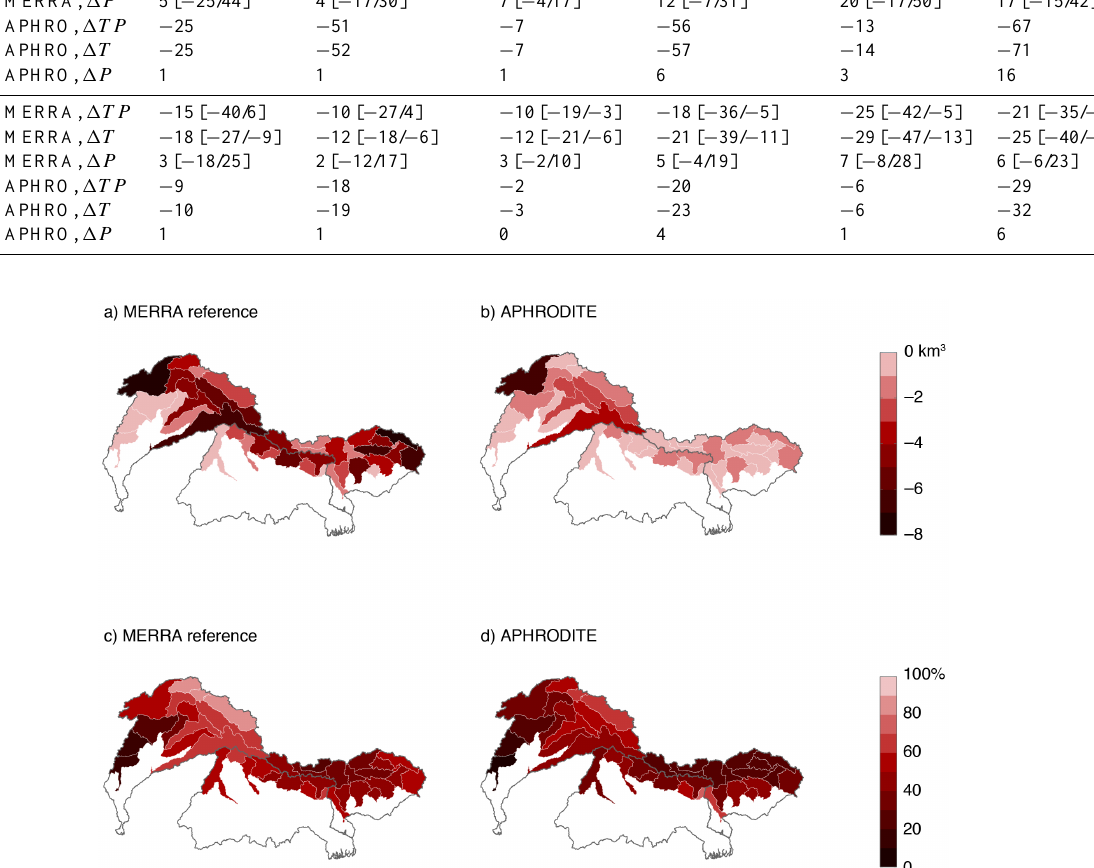
Figure 11. Projected future changes in snowfall in sub-basins of the Indus, Ganges and Brahmaputra basins. (a) Absolute change (km 3 ) with reference to MERRA reference snowfall. (b) Absolute change (km 3 ) with reference to APHRODITE snowfall. (c, d) Corresponding relative changes (%) with reference to MERRA and